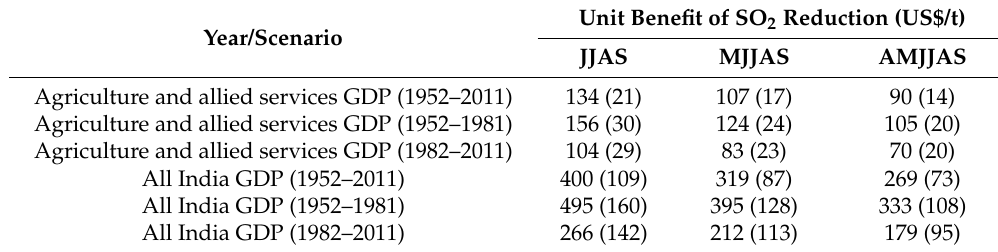
Table 7. As Table 6 based on the linear relationship between ISMR and GDP. The numbers in parentheses are the one sigma uncertainty derived using the standard errors in Table 3.